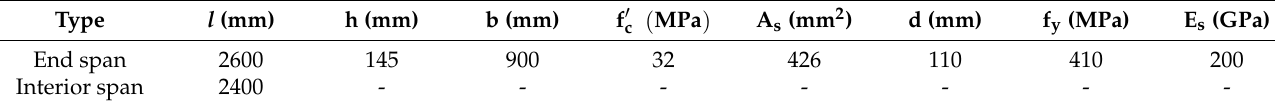
Table 3. Dimensions and material properties of the existing RC slab.